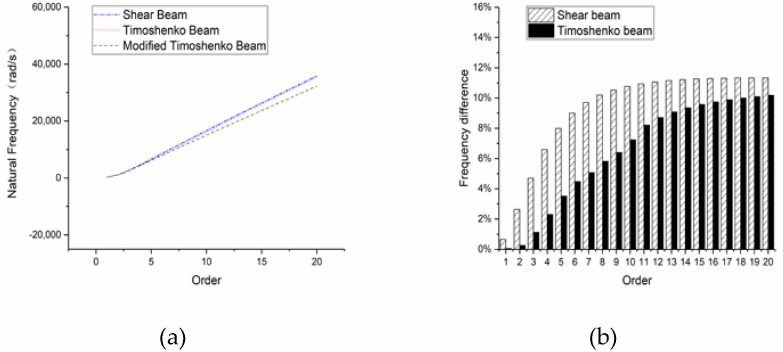
Figure 20. Natural frequencies of the 4-m-long beam: ( a ) overall frequency curve and ( b ) frequency di ff erence compared with a modified Timoshenko beam.